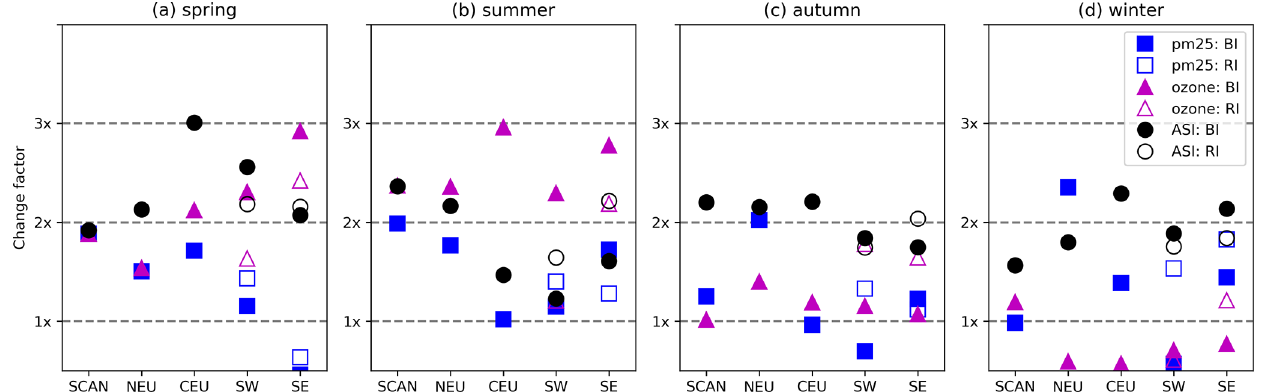
Figure 5. Change in the likelihood of stagnant days (ASI), extreme ozone days, and PM 2 . 5 days under the presence of blocking (BI, shown for all regions) and subtropical ridges (RI, shown only for SW and SE) in (a) spring, (b) summer, (c) autumn and (d) winter. Dashed lines at 1 × , 2 × and 3 × represent no change, a doubling and a tripling in likelihood,